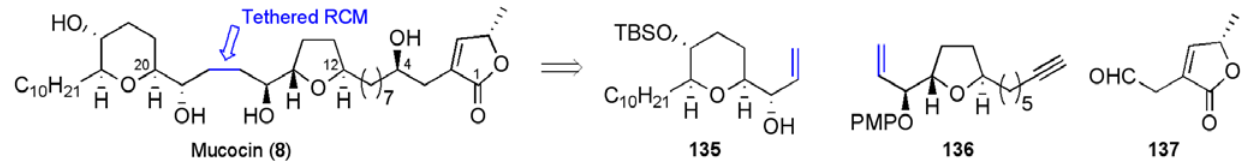
Figure 18. Evans’ route to mucocin ( 8 ) (2003).